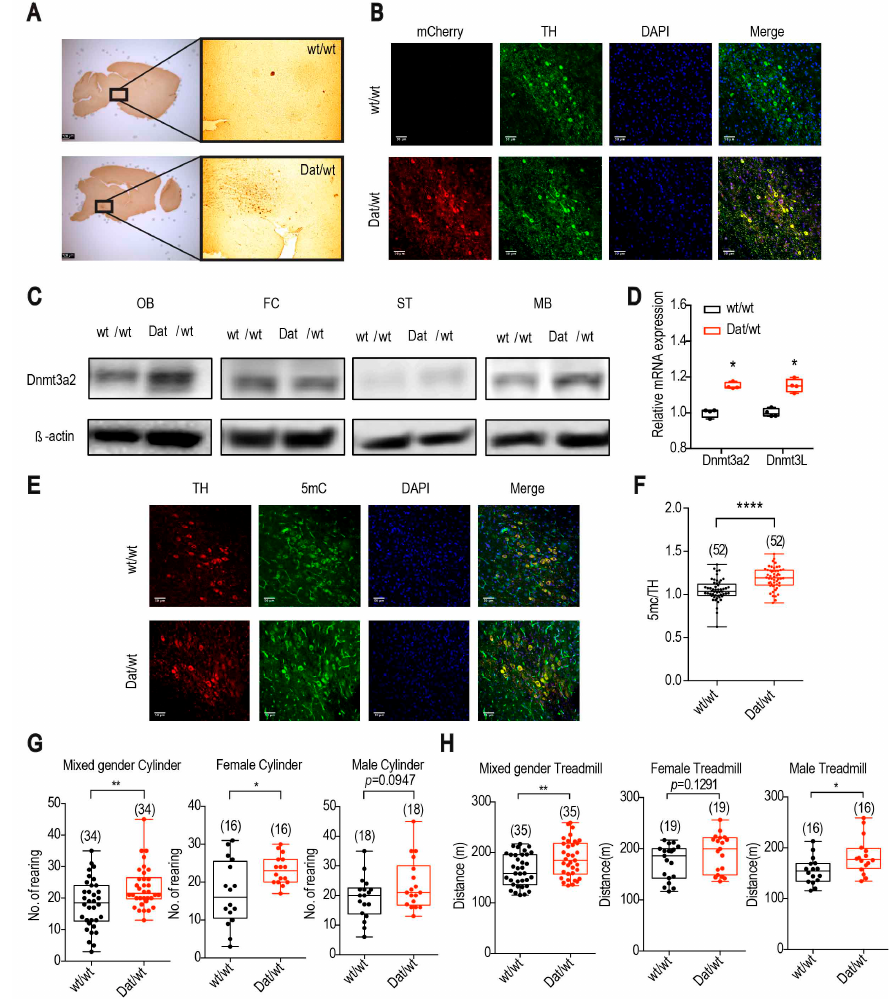
Figure 1. Dnmt3a2/3L specifically overexpressed in dopaminergic neurons, and Dnmt3a2/3L Dat / wt animals showed greater spontaneous activity and higher exercise performance. ( A ) DAB immunohistochemical staining showed that the mCherry reporter was specifically expressed in midbrain areas in Dnmt3a2/3L Dat / wt mice compared to control littermates. ( B ) mCherry was expressed specifically in neurons double labelled for tyrosine hydroxylase (TH) in Dnmt3a2/3L Dat / wt mice. ( C ) Dnmt3a2 expression level detected by western blot was increased in the olfactory bulb (OB), striatum (ST) and midbrain (MB) in Dnmt3a2/3L Dat / wt mice. ( D ) qRT-PCR of Dnmt3a2 and Dnmt3L was shown an elevated expression in midbrain of Dnmt3a2/3L Dat / wt mice. ( E ) 5mC staining showed stronger fluorescence intensity in TH positive cells in Dnmt3a2/3L Dat / wt mice. ( F ) Quantification for the DNA methylation of TH positive cells was significantly higher in Dnmt3a2/3L Dat / wt mice. ( G ) Dnmt3a2/3L Dat / wt mice exhibited a higher spontaneous activity in the cylinder test in mixed gender and female groups, no significance but the same trend was found in the male group. ( H ) Dnmt3a2/3L Dat / wt mice showed a higher exercise performance on the treadmill in mixed gender and male groups, no significance but the same trend occurred in the female group. Values are reported as the mean ± SEM. * p < 0.05, ** p < 0.01, **** p < 0.0001. Student t -test has been used for comparison between Dnmt3a2/3L wt / wt and Dnmt3a2/3L Dat / wt .